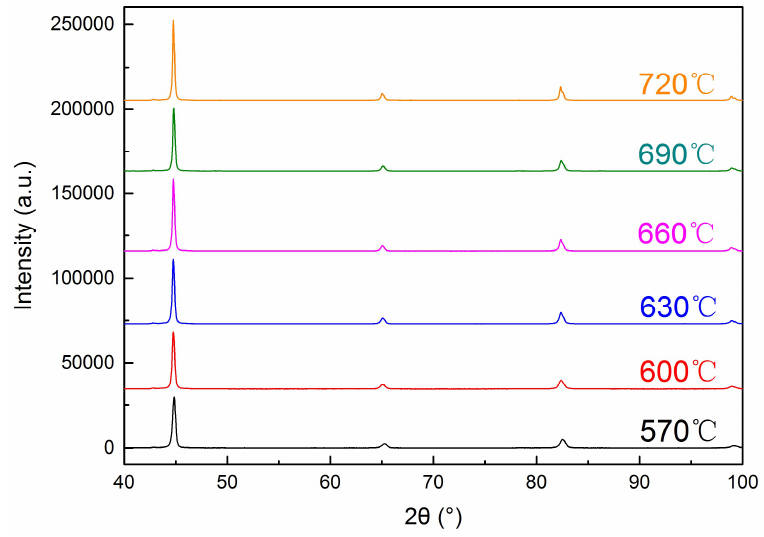
Figure 7. XRD spectra of 42CrMo4-V steel tempered at 570–720 °C.